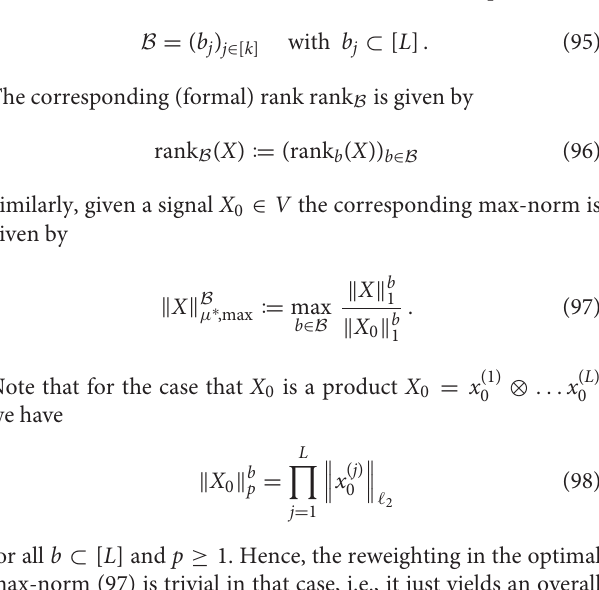
Frontiers in Applied Mathematics and Statistics |